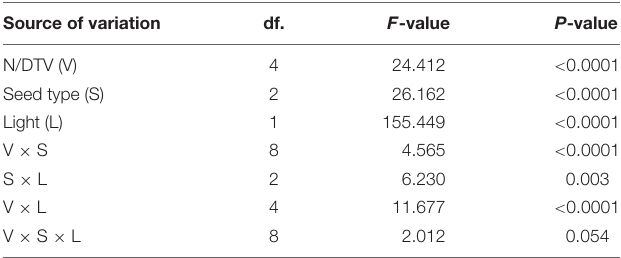
TABLE 4 | Three-way ANOVA of effects of night/day temperature variation (N/DTV), seed type, light and their interactions on seed germination of S. ferganica. Source of